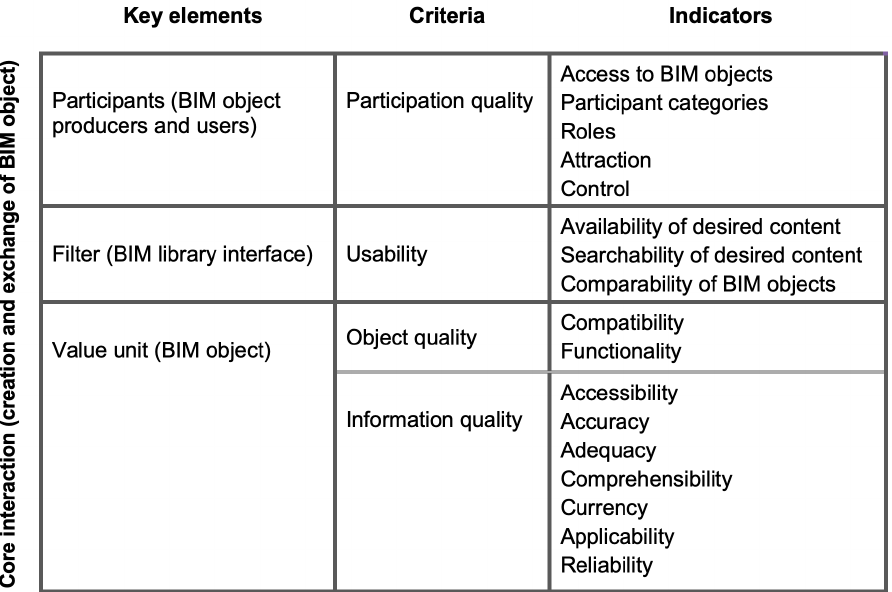
Fig. 3. Matrix for the qualitative analysis of BIM library platforms Table 1. The characteristics of a sustainable innovative product represented by its BIM object to enable its diffusion (After Rogers, 2003) Relative